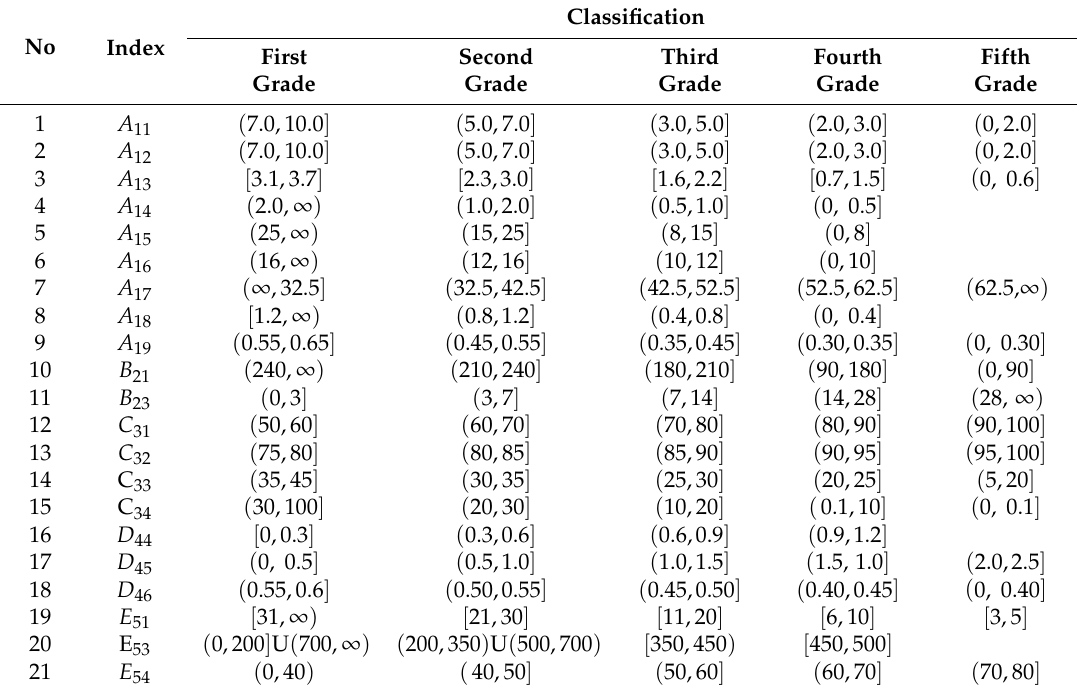
Table 1. Evaluation indices and grading standards.